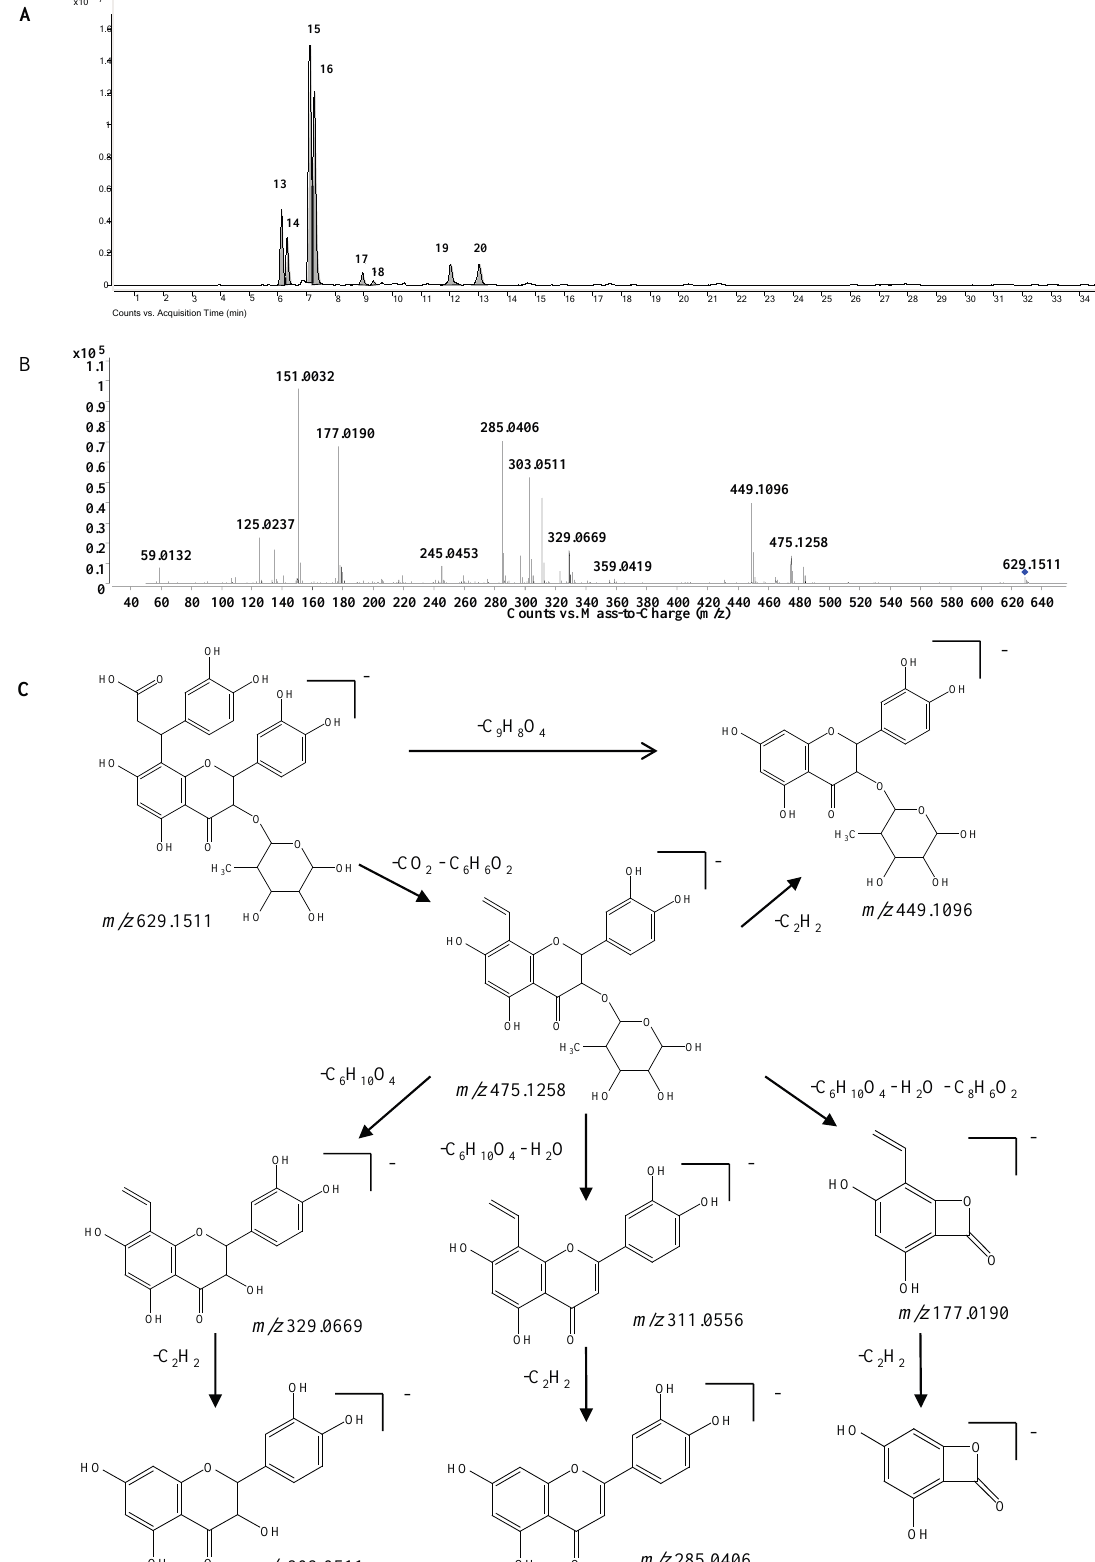
Figure 5. ( A ) Extracted ion chromatogram (EIC) of compound 13 – 20 ; ( B ) MS/MS spectrum of compound 13 ; ( C ) proposed fragmentation pathway of compound 13